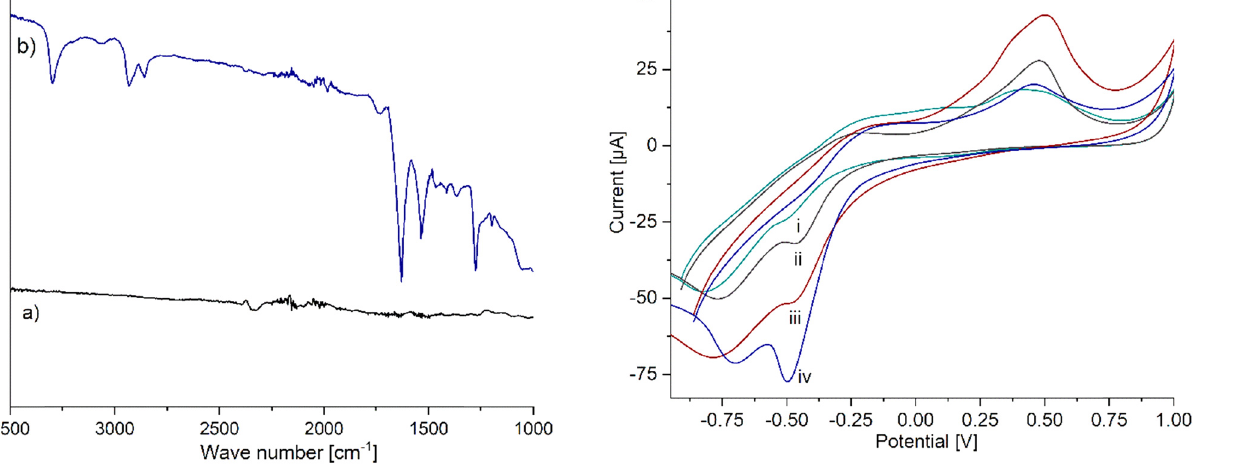
Figure A1: FTIR spectra of ( a ) MWCNT and ( b ) cMWCNT.